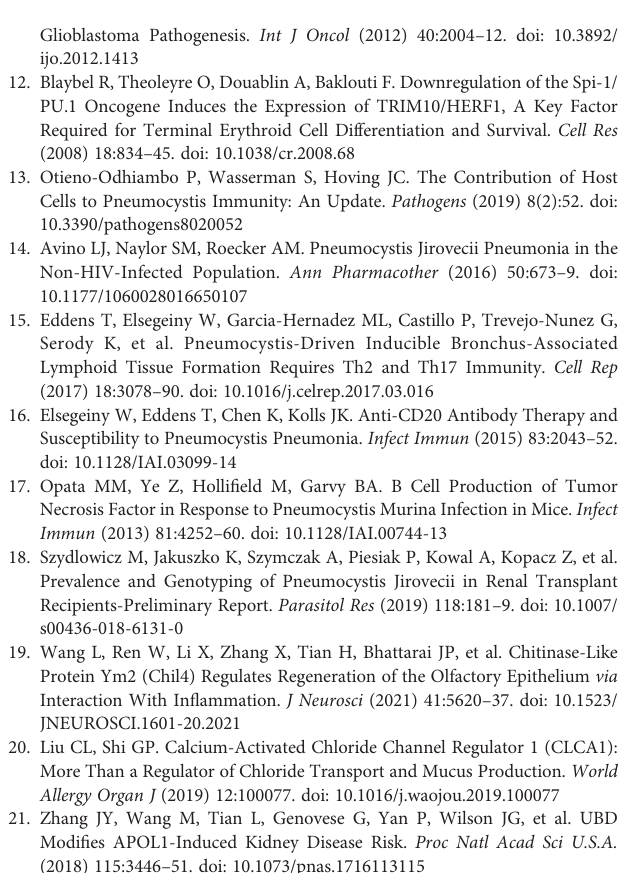
Supplementary Figure 2 | The sequencing data of the transcriptomics analysis of lung tissue. (A) Saturation of all the genes were detected. (B) The RPKM density distribution map of genes. (C) The results of PCA analysis of samples. Supplementary Figure 3 | Methodology work fl